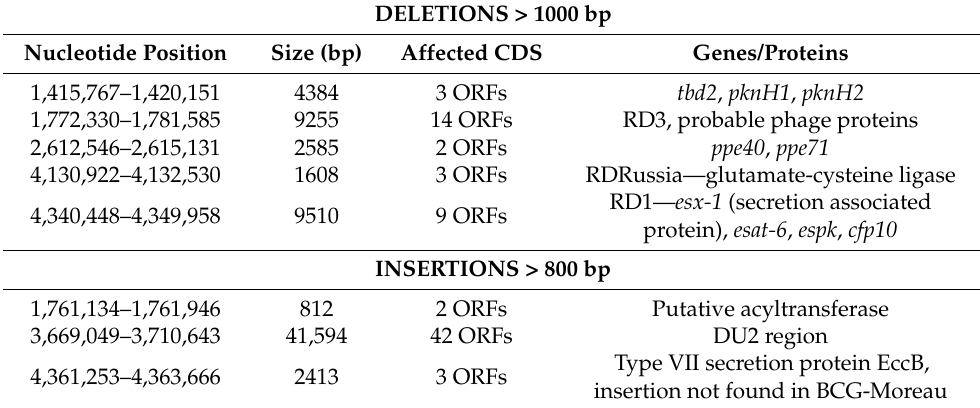
Table 3. Comparative genomics analysis of BCG-Sofia as compared to reference M. bovis genome sequence